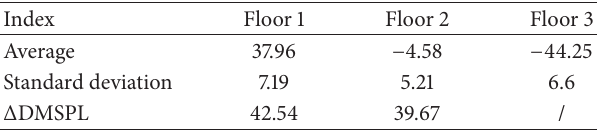
Table 1: Average and standard